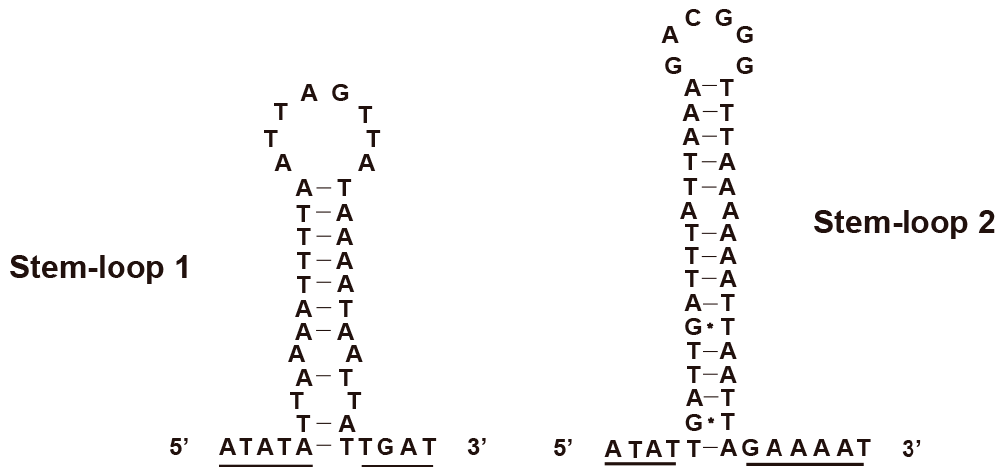
Figure 7. Structure elements found in the mitochondrial control region of H. sinicus . The underline indicates conserved sequences.